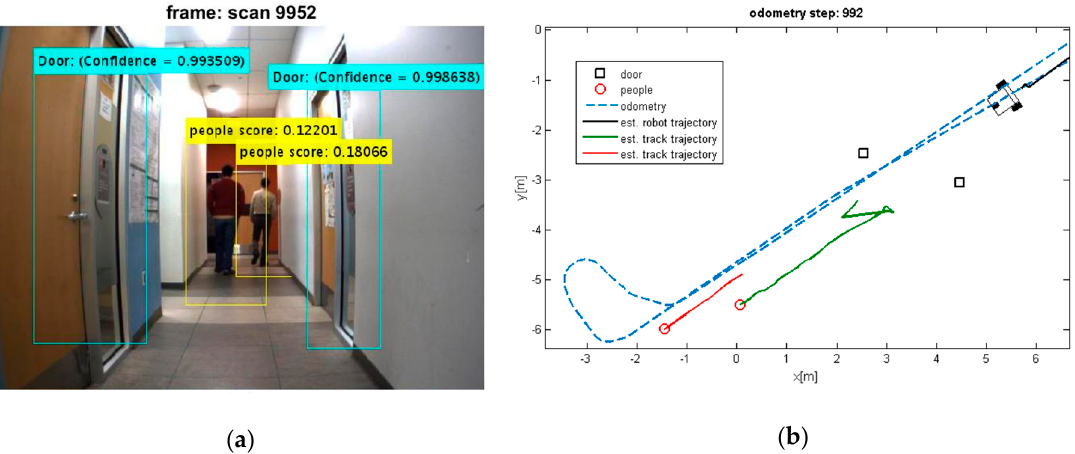
Figure 11. ( a ) Detected moving people and detected doors; ( b ) Estimated trajectories of robot and tracks along with the estimated position of doors.